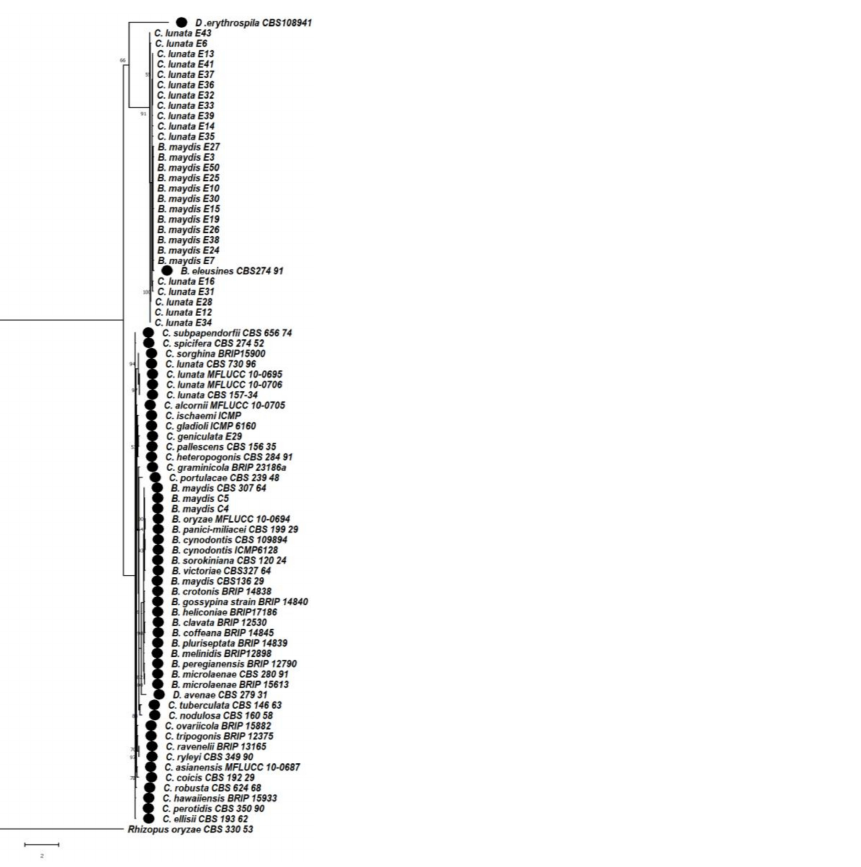
Figure 9. Maximum likelihood phylogeny based on combined internal transcribed spacer (ITS) and (GAPDH). Sequenced data of the Bipolaris maydis and Curvularia lunata isolates were inferred with Raxml based on GTR + Gamma model. Numerical value presented in the node indicates bootstrap value with a 1000 non-parametric bootstrap replicates analysis. Drechslera avenae CBS 279.31, Drechslera erythospila (sexual stage- Pyrenophora erythospila) CBS 108,941 were used as other genera from Helminthosporoid group. The symbol • denotes as ‘ ex-type ’ 43 closely related species sequences obtained from GenBank. Rhizopus oryzae used as an